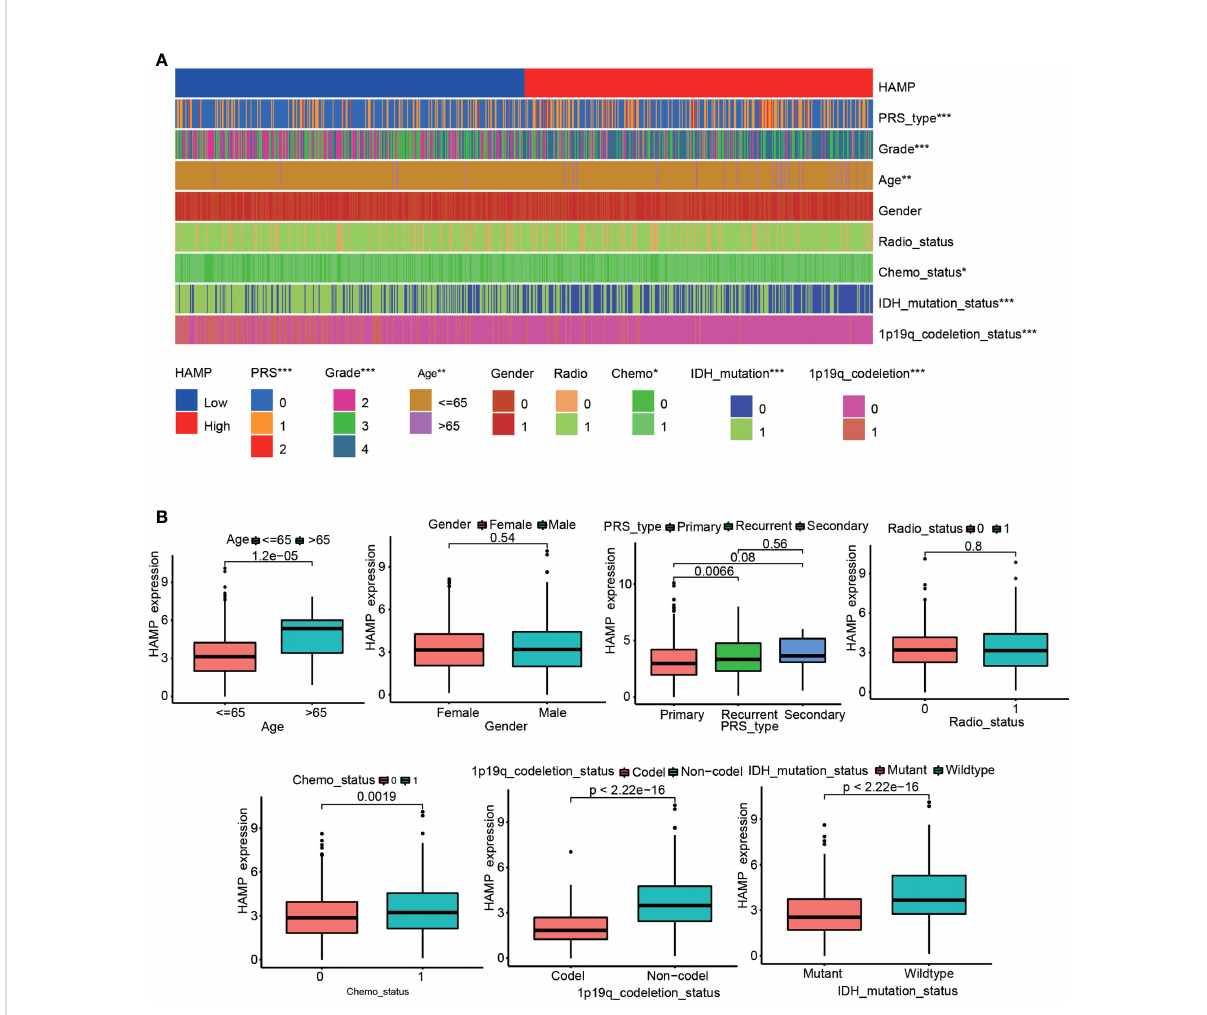
FIGURE 3 Analysis of the relationship between hepcidin expression and the clinical features of patients included in the CGGA glioma dataset. (A) The relationship between hepcidin expression and clinical features of patients in the CGGA dataset. (B) Each clinical feature was analyzed for differences of hepcidin expression in different groups. * p < 0.05, ** p < 0.01, and *** p <